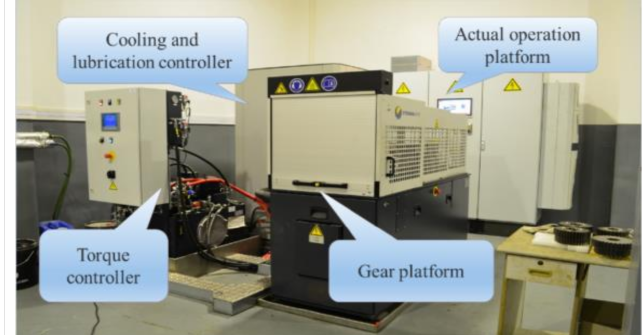
Figure 8. The test bench of gearbox fatigue